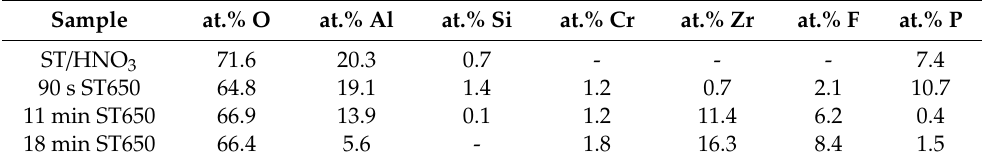
Figure 16. High-resolution XPS spectra of ( a ) Cr 2p , ( b ) Zr 3d and ( c ) F 1s recorded for AA3003 samples after chemical treatment using ST / HNO 3 and then coated using 10% ST650 conversion coatings prepared at di ff erent conversion times: 90 s, 11 min and 18 min at room temperature. Spectra were not normalized on the intensity scale. Table 8. The concentrations of elements obtained by XPS analysis of chemically cleaned AA3003 and after being coated with 10% ST650 conversion coatings prepared at di ff erent conversion times: 90 s, 11 min and 18